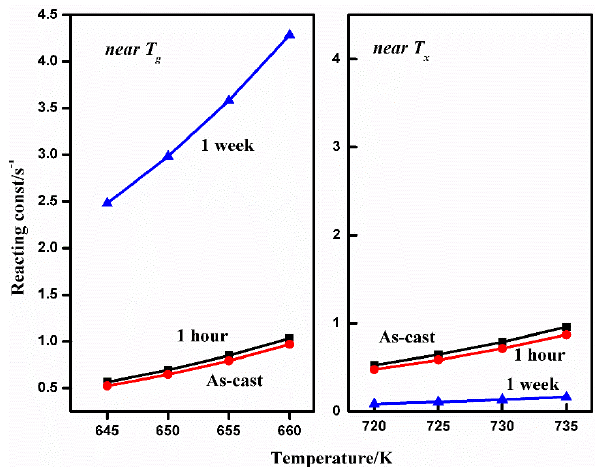
Figure 5. k – T curves of alloys with different annealing times in CT.